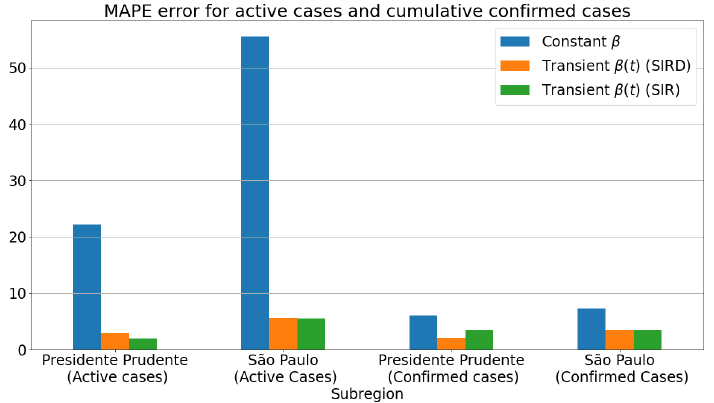
Figure 8. Comparison of MAPE errors for constant and transient values of β : SIR and SIRD models.